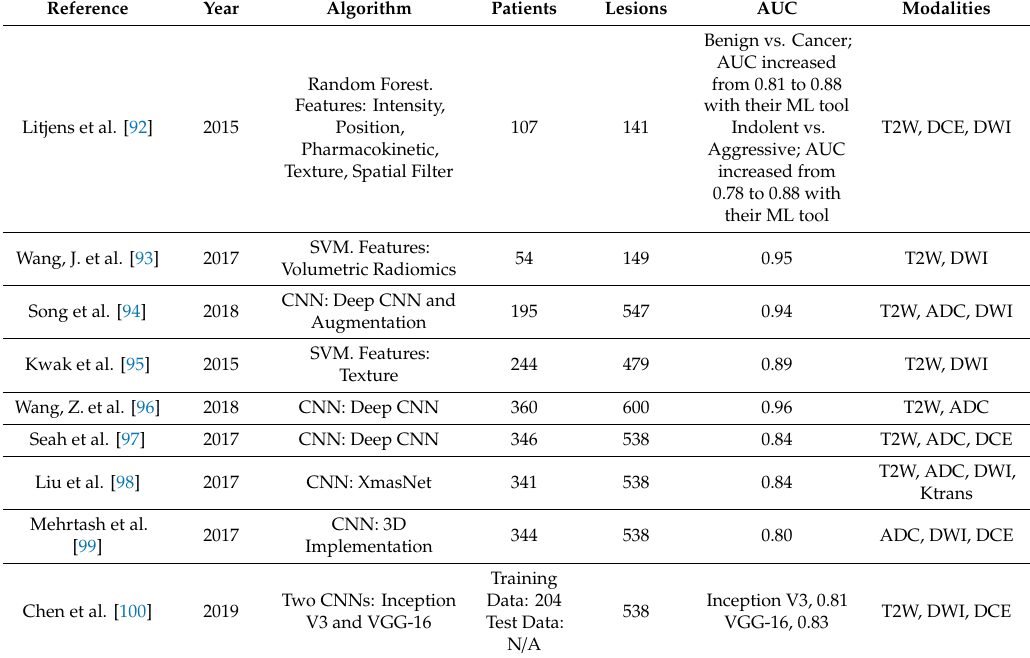
Table 4. Machine-learning techniques applied to prostate lesion characterization.